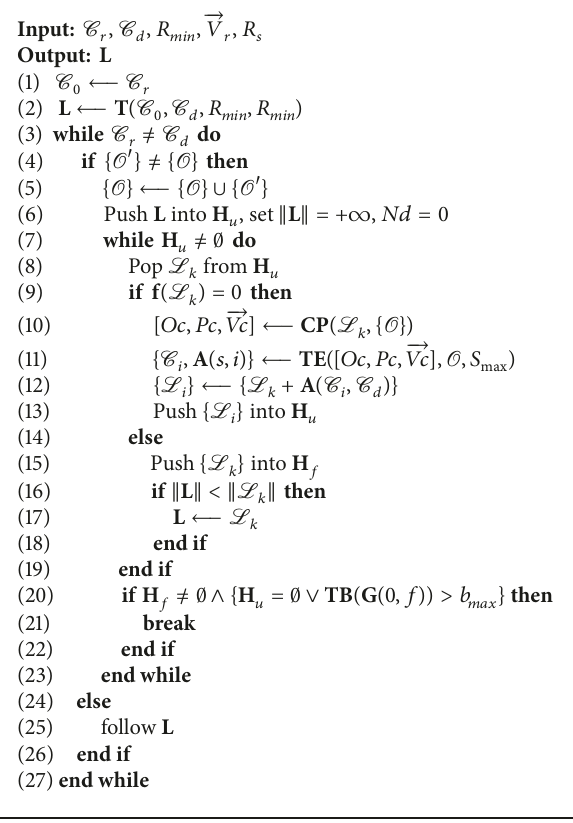
Algorithm 1: The smooth path planning